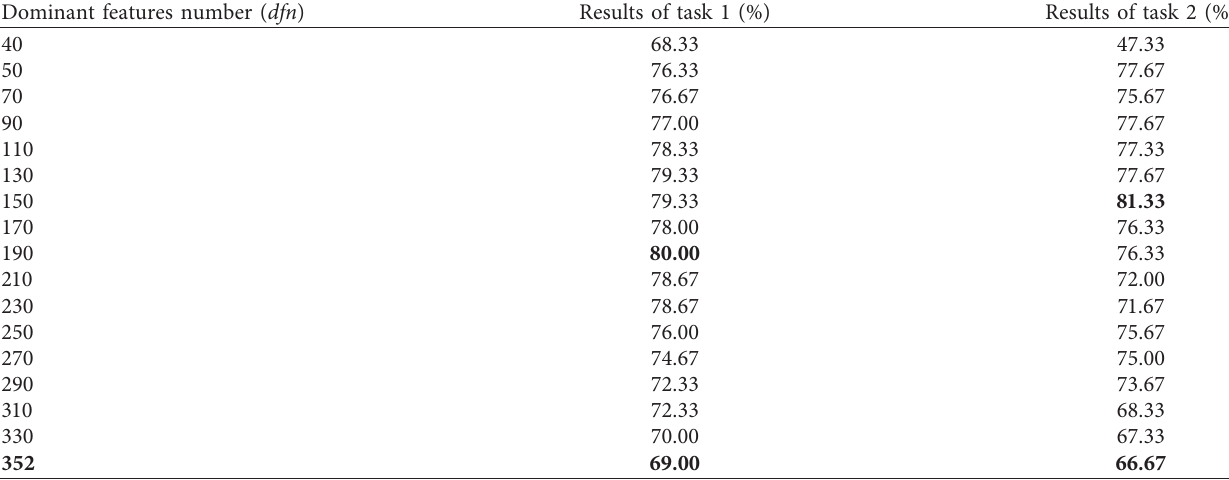
Figure 14: The diagram of cross-domain fault diagnosis results of TFDD framework. Table 4: Cross-domain fault diagnosis results of TFDD